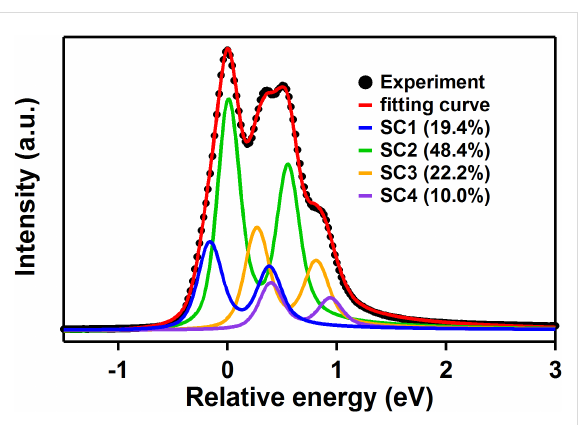
Figure 4: Ge 3d core-level spectrum obtained at a photon energy of 135 eV in normal emission. The dots are the experimental data and the fitting curve is the sum of the SC1 to SC4 components. The rela- tive intensities of the four components are shown as a percentage of the total area in the figure. Fitting parameters: Spin-orbit split: 0.545 eV, Branching ratio: 0.67 for SC1 and SC2, 0.63 for SC3 and SC4. Gaussian widths: 177, 163, 183 and 174 meV, respectively, Lorentzian width: 110 meV. The asymmetry parameter of the Doniach–Šunji ć line profile is 0.06. The energy shifts with respect to SC2 are − 167, +269 and +389